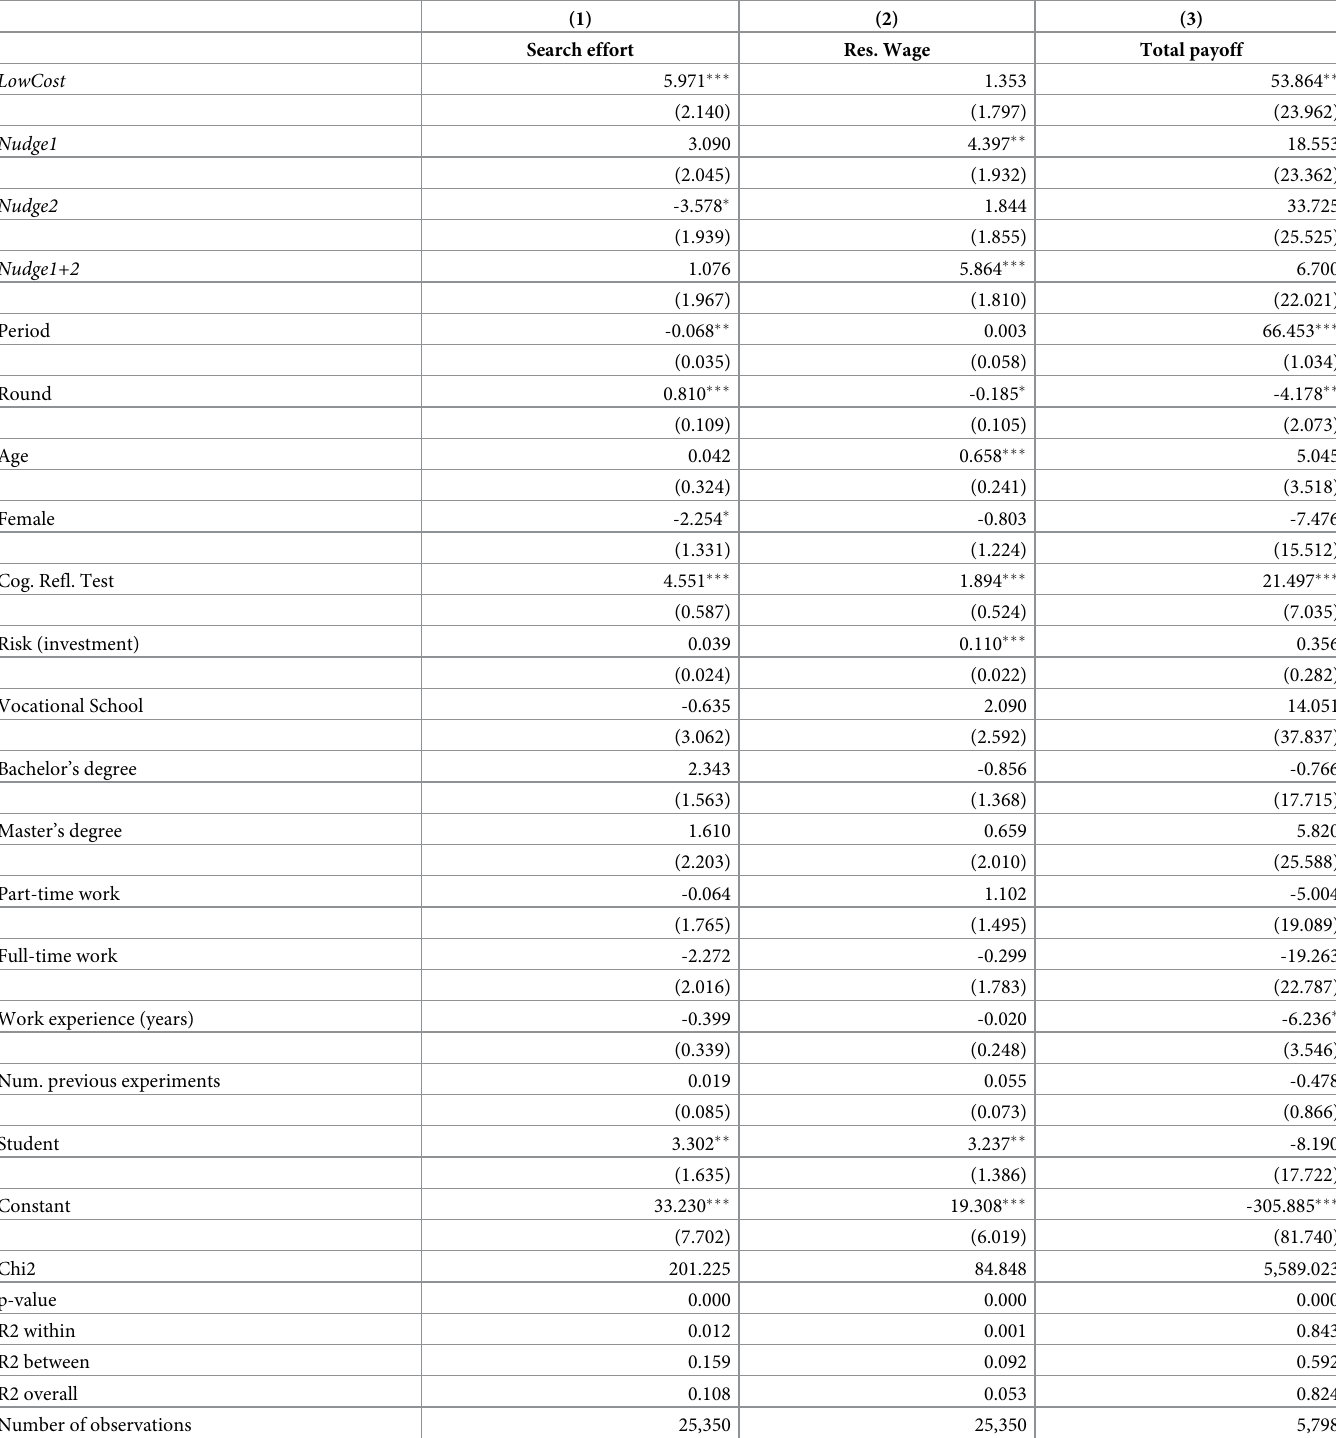
Table 4. Treatment